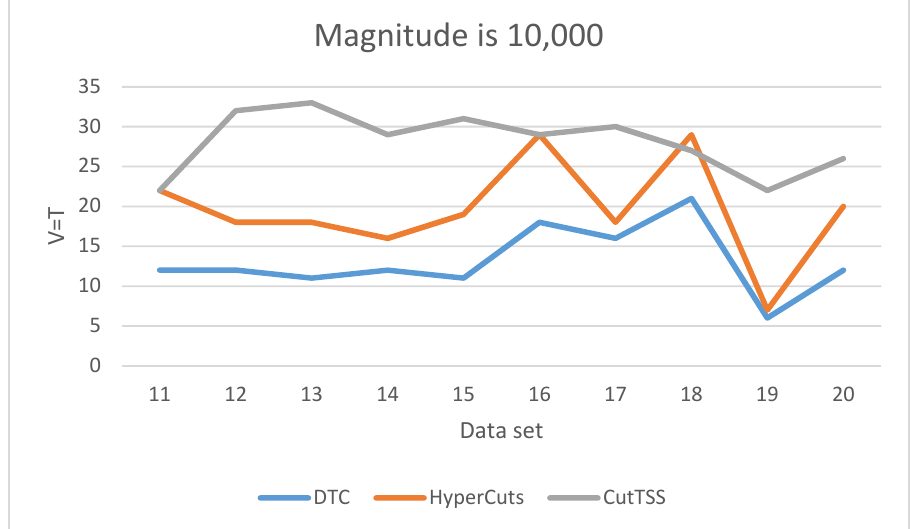
Figure 6. The experimental result when V = T and the data magnitude is 10,000.